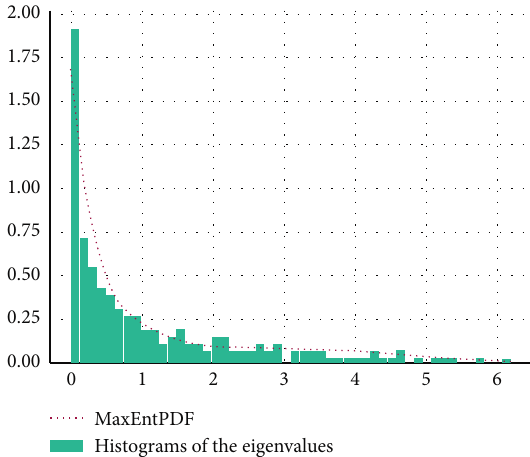
Figure 4: d � 1000, n � 500, alpha � 0.5, and beta �